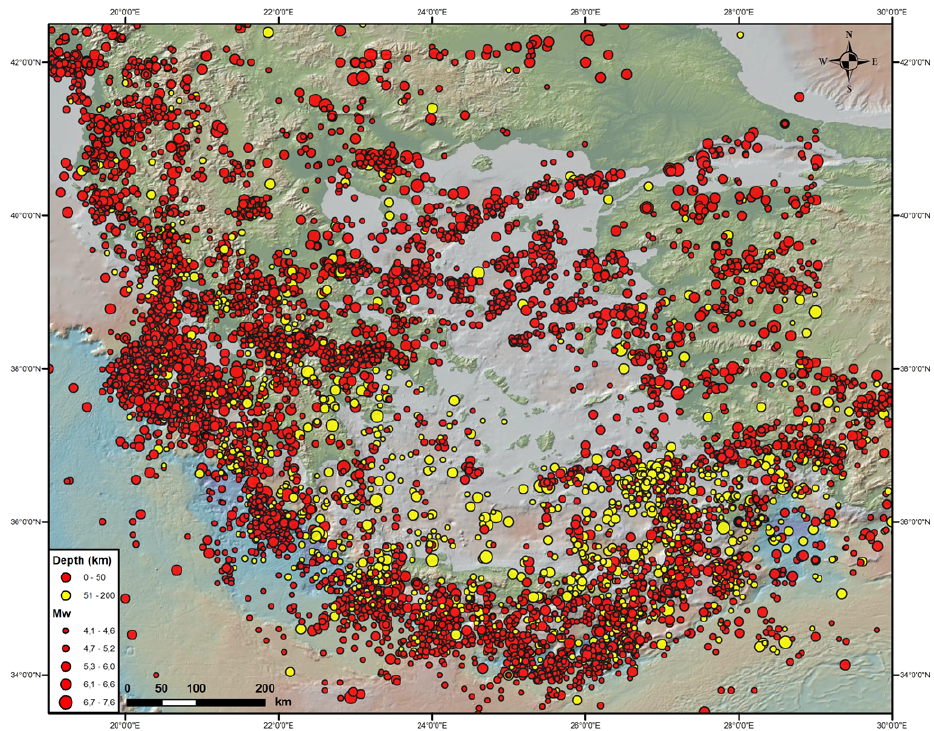
Fig. 2. Spatial distribution of the epicentres of both shallow and intermediate depth earthquakes in Greece and adjacent areas during the period 1900–2009.